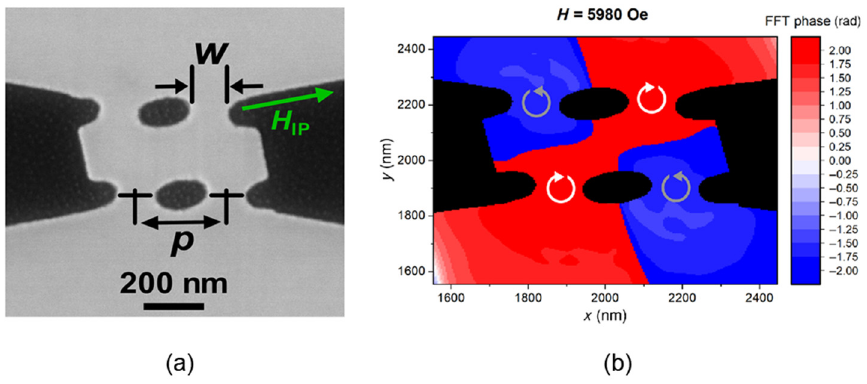
Figure 14. ( a ) SEM image of the 2 × 2 spin Hall nano-oscillator array; ( b ) phase image of the 2 × 2 spin Hall nano-oscillator array [52]. Table 1. Performance of different types of oscillator-network-based Ising